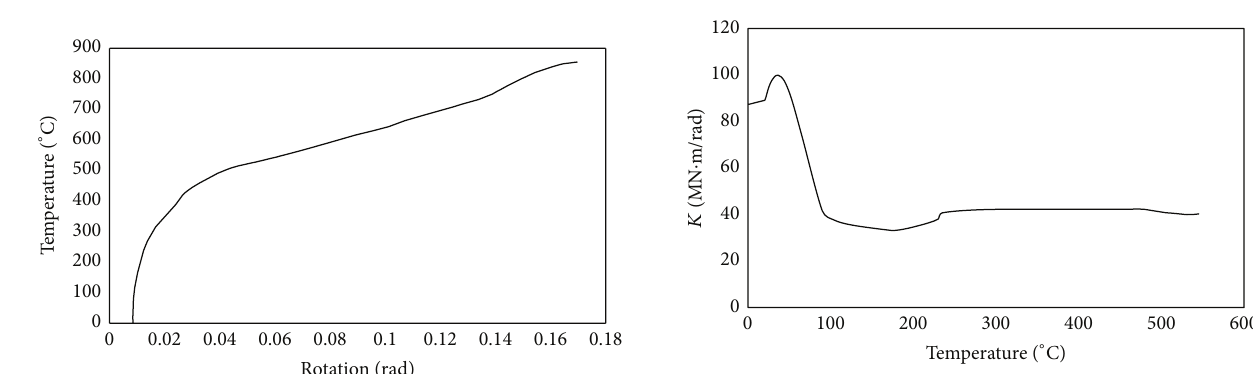
to the fire. Also through comparing the stiffness of these three connections it can be understood that the more the cross section of the beam-to-column connection is the better the distribution of tension on panel zone occurs and since the stiffness of panel zone is more it reduces with delay. The proportion of minimum stiffness in the case of applying heat to maximum stiffness for the connection with the end plate, plate cover connection, and T joint is 0.37, 0.10, and 0.30, respectively, which indicate that the decrease in stiffness is less than the maximum stiffness in connection with end plate.